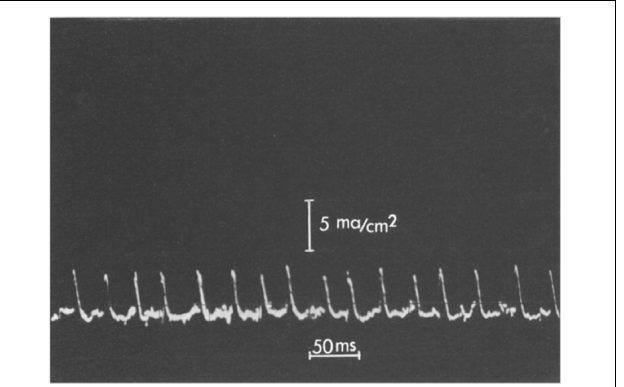
FIGURE 6 | Oscillatory behavior of a poly(glutamic acid)—Ca 2 + membrane. The amplitude scale is 5 mA/cm 2 and the time scale is 50 ms per division. From Huang and Spangler (1977).